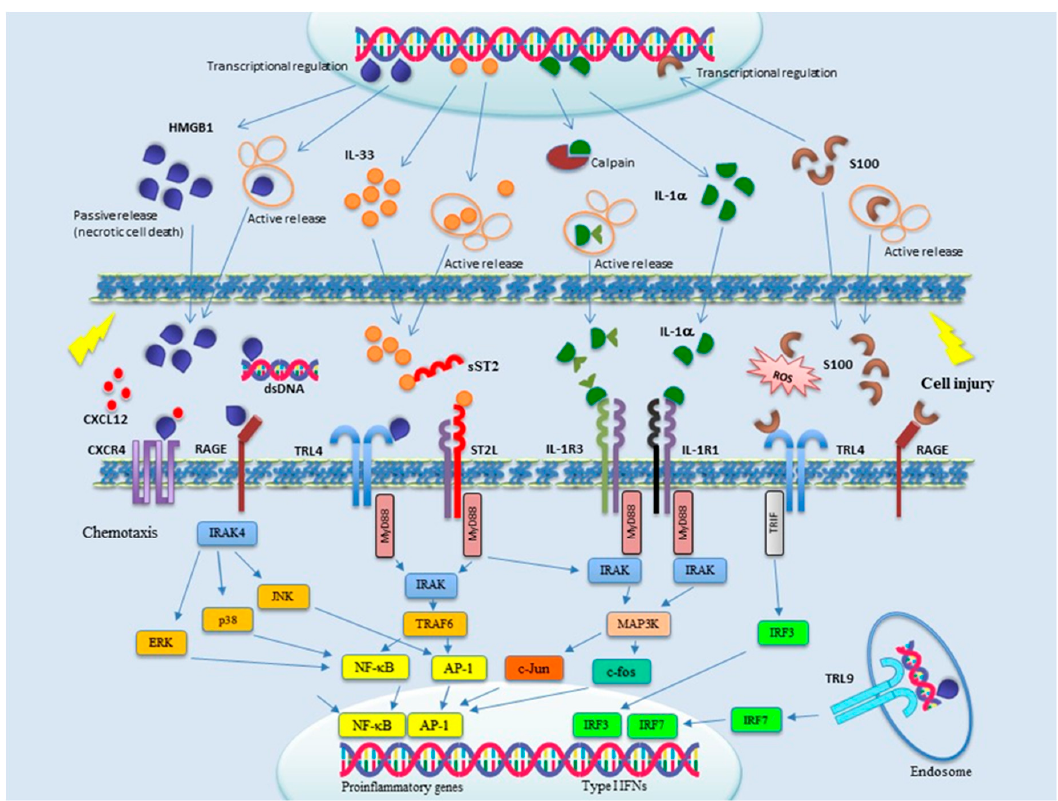
Figure 1. Signal transduction of the main alarmins involved in SSc pathogenesis. Upon cell injury, alarmins are released both actively and passively into the microenvironment, where they are sensed by membrane-bound receptors mainly belonging to the toll-like receptor (TLR) and IL-1R families. Multiple signal transduction pathways are thereby activated, culminating in the transcriptional activation of proinflammatory and type I interferons (IFNs) genes. Alarmins are therefore attractive targets for novel pharmacological intervention, but only a few clinical trials are currently ongoing to evaluate the effects of alarmin blockade on human diseases.